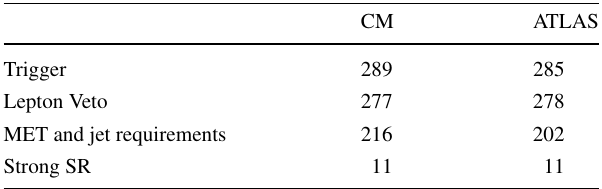
Table 3 Cutflow comparison for a chargino produced in strong pro- duction channel with ( m ˜ g , m ˜ χ